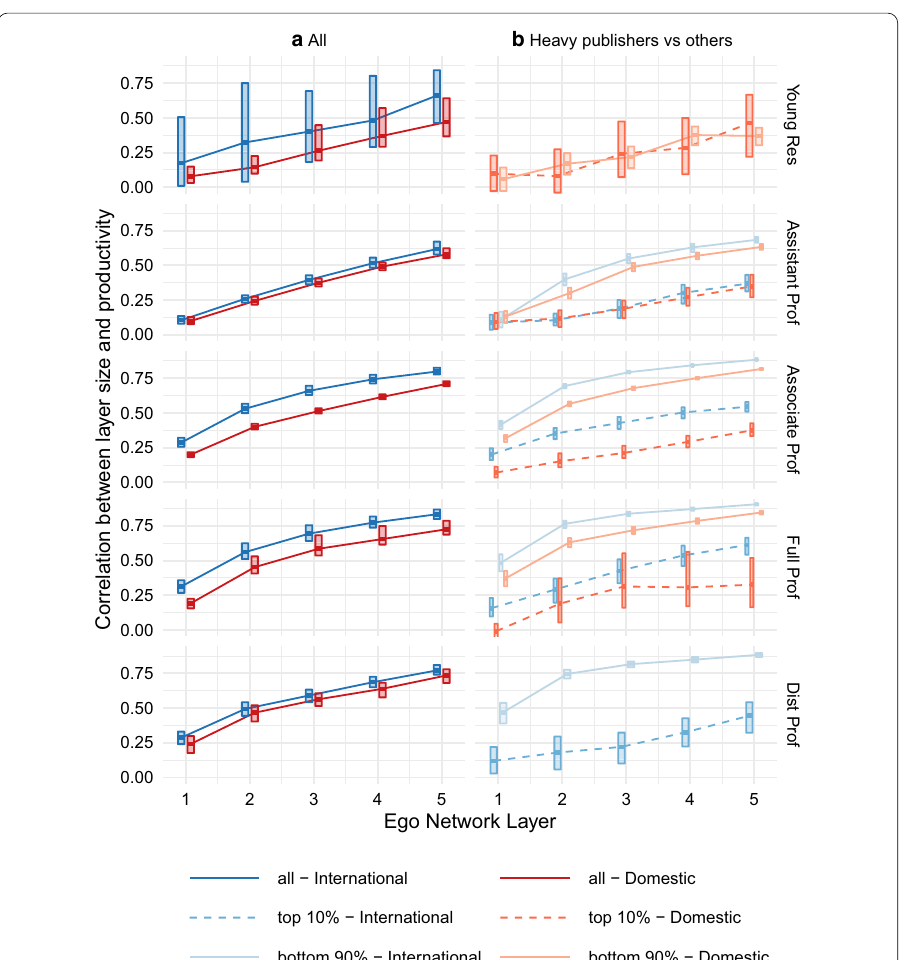
Fig. 10 Productivity and co-authorship ego networks for international (blue) and domestic (red) migrants Correlation between ego network layer size and number of publications. Dashed lines are used for heavy publishers